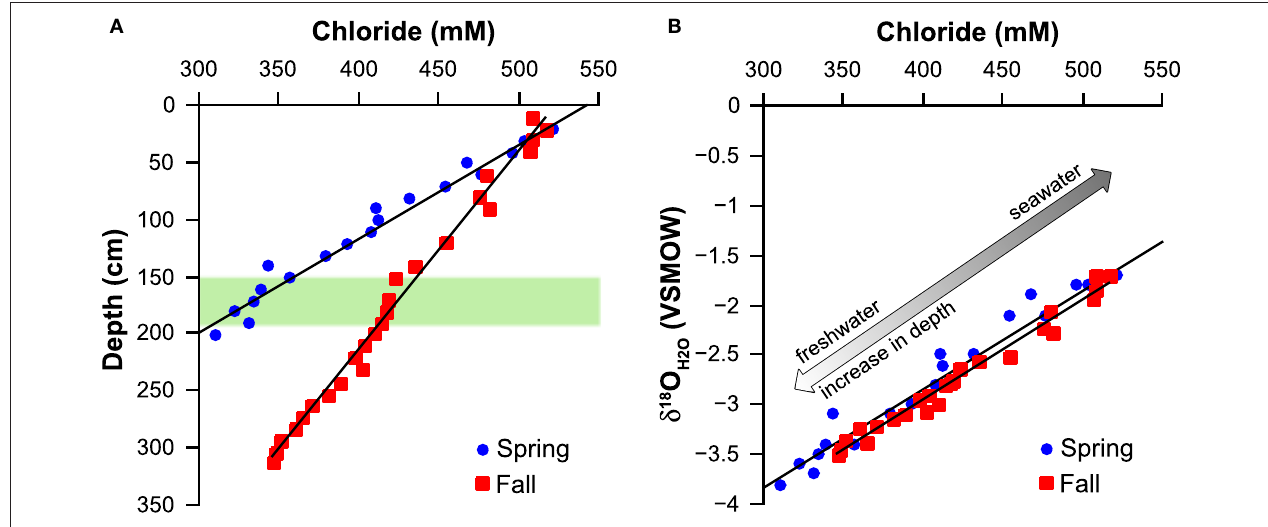
FIGURE 3 | (A) Chloride concentration vs. depth. Intercept at chloride = 0 indicates a freshwater source at 441 and 908cm for Spring and Fall, respectively. (B) Chloride concentration vs. oxygen isotope composition of pore water intercept at chloride = 0 yields an oxygen isotope composition of the underlying freshwater source of ∼ − 7 ‰ ( − 6.78 ‰ Spring and − 6.96 ‰ Fall). The green band represents the SMT.